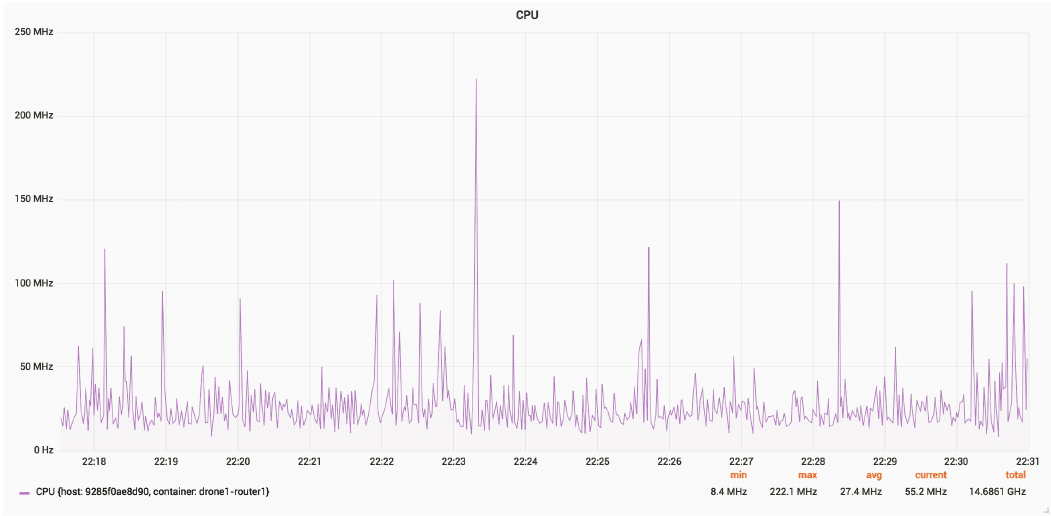
Figure 26. CPU usage for a router.